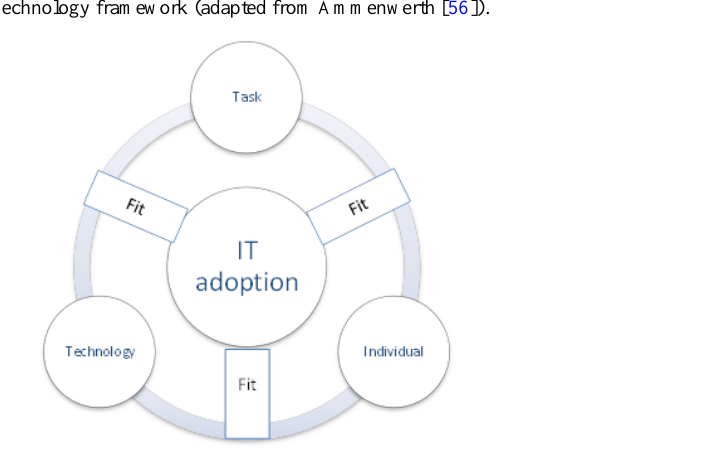
Figure 2. Fit between Individual Task and Technology framework (adapted from Ammenwerth